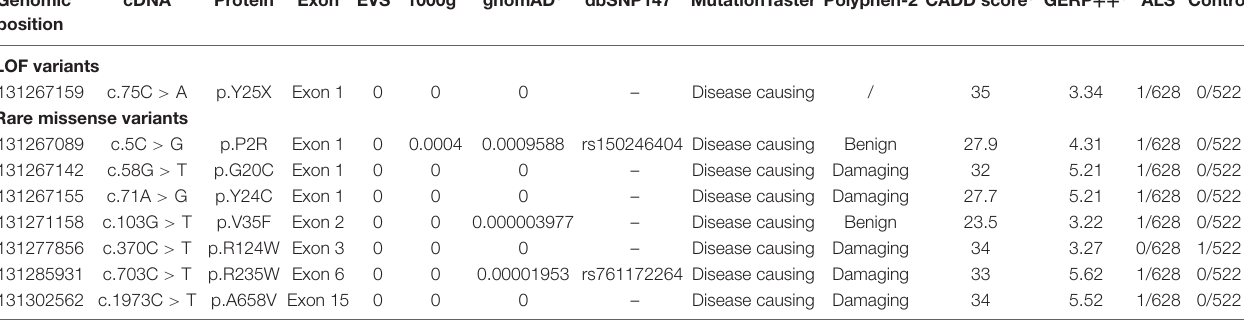
TABLE 2 | Rare coding variants identified in the GLE1 gene. Genomic